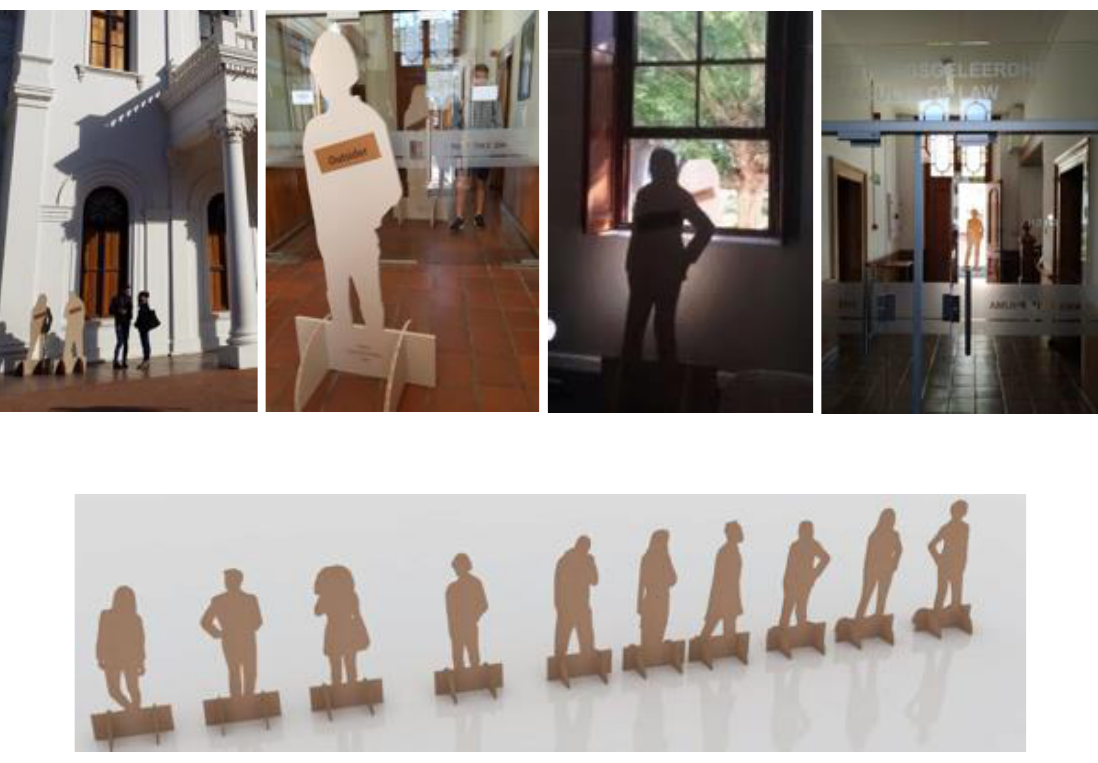
Figure 3 : Life-size figures in and outside the Faculty of